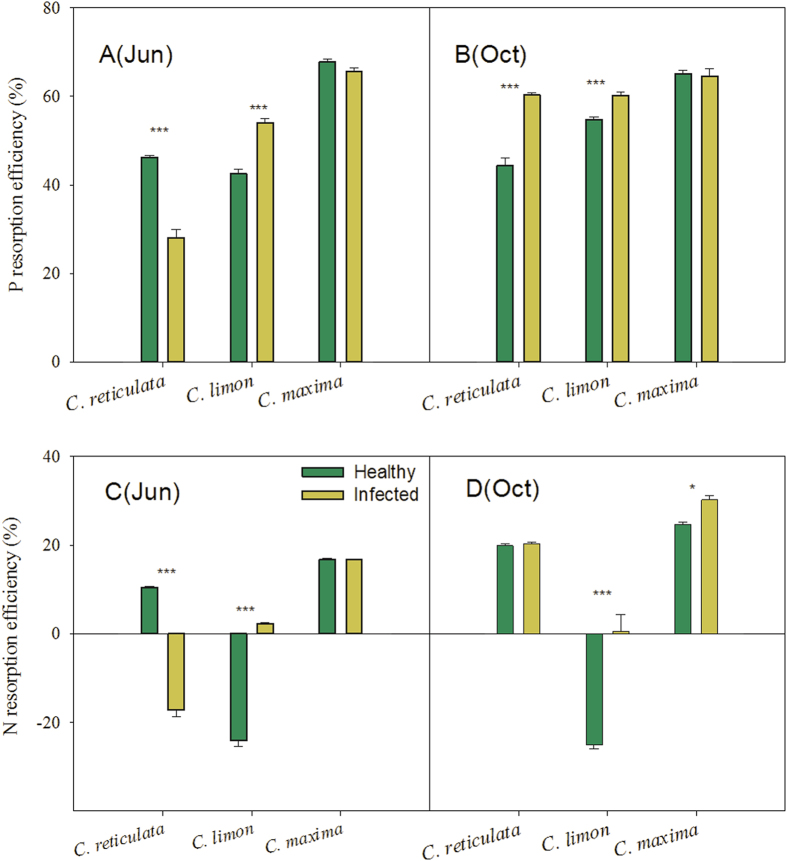
P (a,b) and N (c,d) resorption efficiencies of different citrus species.Values are mean±Se, n = 5. *, ** and *** above bars indicate significant differences at P < 0.05, 0.01 and 0.001, respectively, derived from the results of paired t-tests.